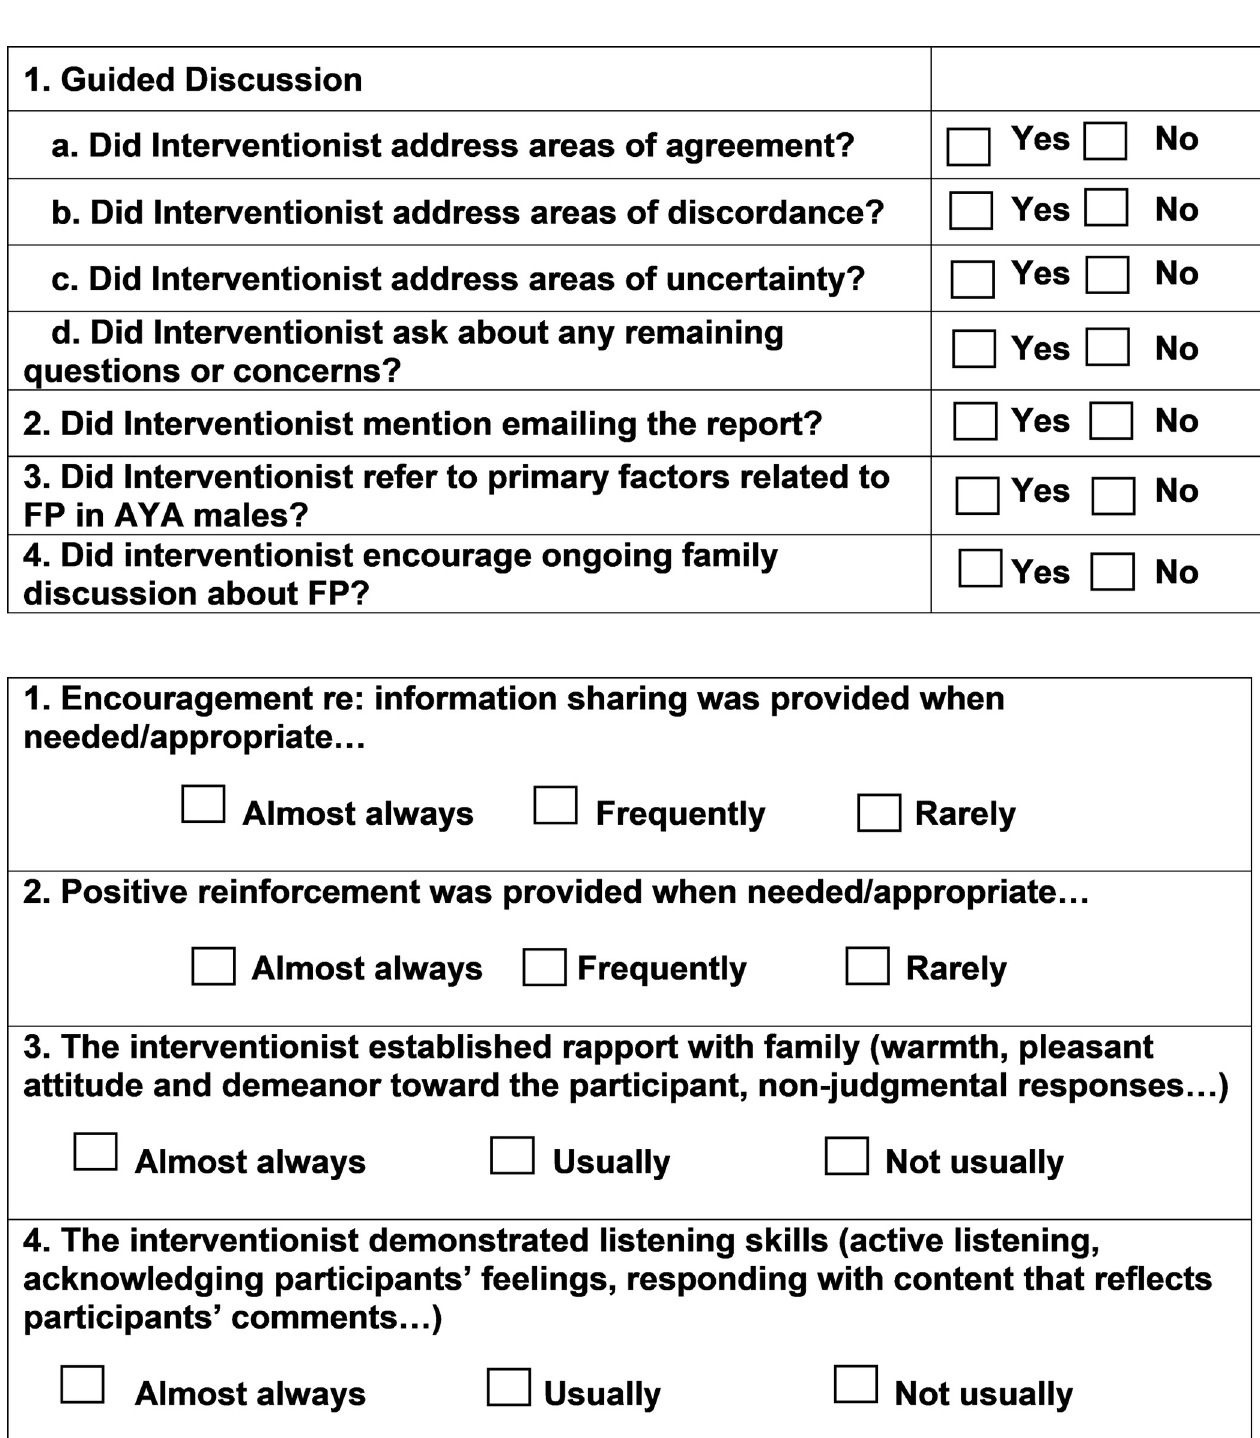
Fig 2. Fidelity checklist.